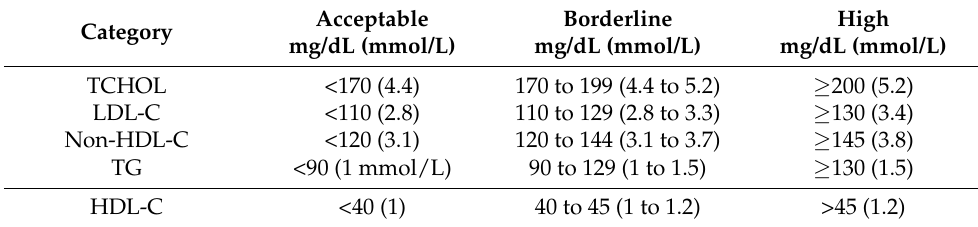
Table 1. Plasma lipid and lipoprotein level cut-off